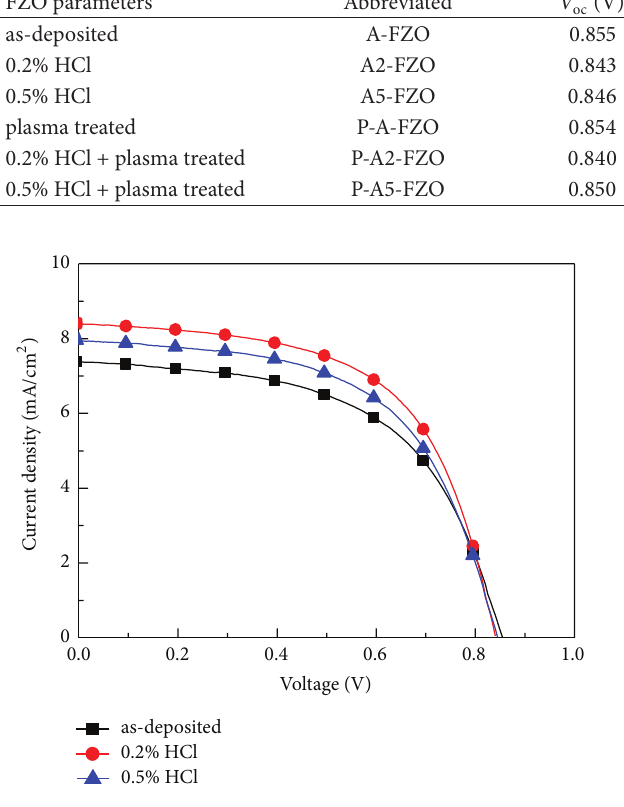
Figure 9: Current-voltage characteristics of the p-i-n 𝛼 -Si:H thin film solar cells under illumination.